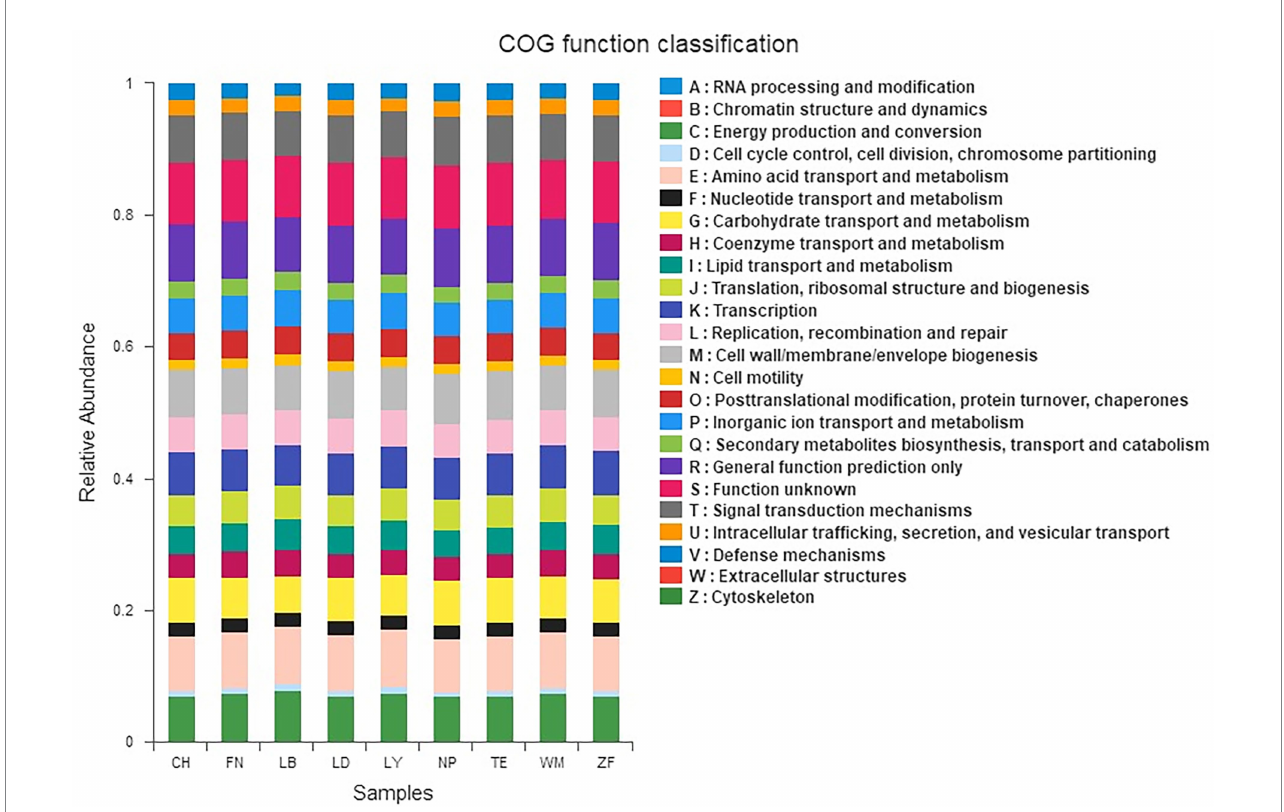
FIGURE 4 COG (clusters of orthologs groups) functional classification of the rhizobacterial communities across nine sample sites. The x-axis represents samples and the y-axis represents relative abundance presented as a